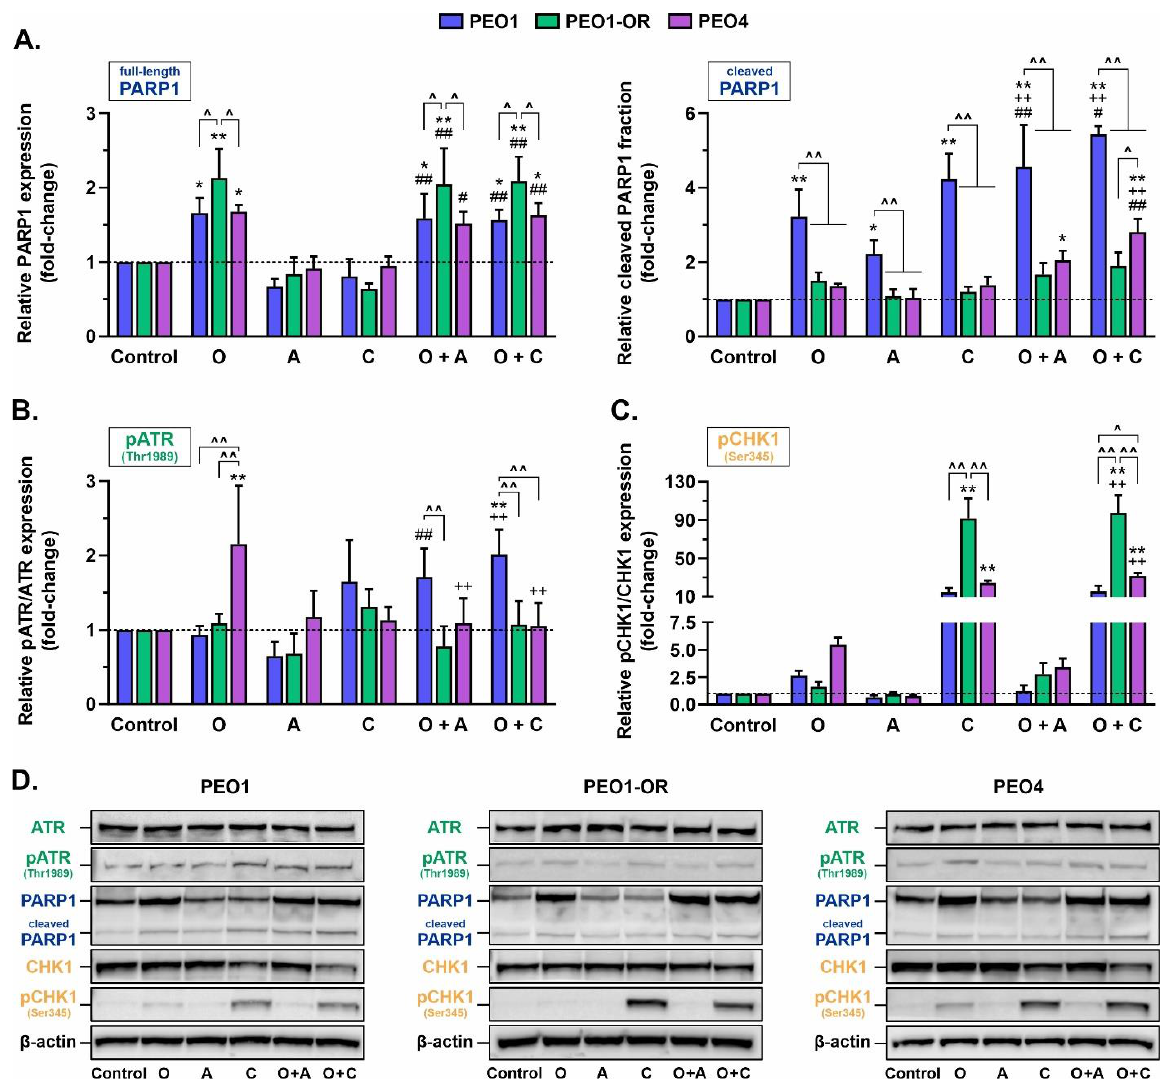
Figure 5. Monotherapy with olaparib, ATRi, and CHK1i or their combinations alter the expression and phosphorylation levels of targeted proteins and PARP1 cleavage in a cell-dependent manner. Quantitative Western blot analysis of ( A ) full-length and cleaved PARP1, ( B ) total and phosphorylated ATR (Thr1989), and ( C ) total and phosphorylated CHK1 (Ser345) in OC cell lines. Cells were incubated with olaparib (O, 5 μM), ATRi (A, 0.5 μM), CHK1i (C, 2.5 μM) , or their combinations for 48 h, and whole-cell lysates were prepared immediately afterward. Protein levels were quantified following normalization to β -actin and calculated as fold-change relative to untreated controls. The results are presented as mean ± SD ( n = 3). Statistical significance was assessed using two-way ANOVA f ollowed by Tukey’s test. ^ p < 0.05, ^^ p < 0.01: differences between cell lines; * p < 0.05, ** p < 0.01: treatment vs. control; ++ p < 0.01: olaparib vs. combinations with ATRi or CHK1i; # p < 0.05, ## p < 0.01: ATRi or CHK1i vs. respective combinations with olaparib. ( D ) Representative Western blot images.